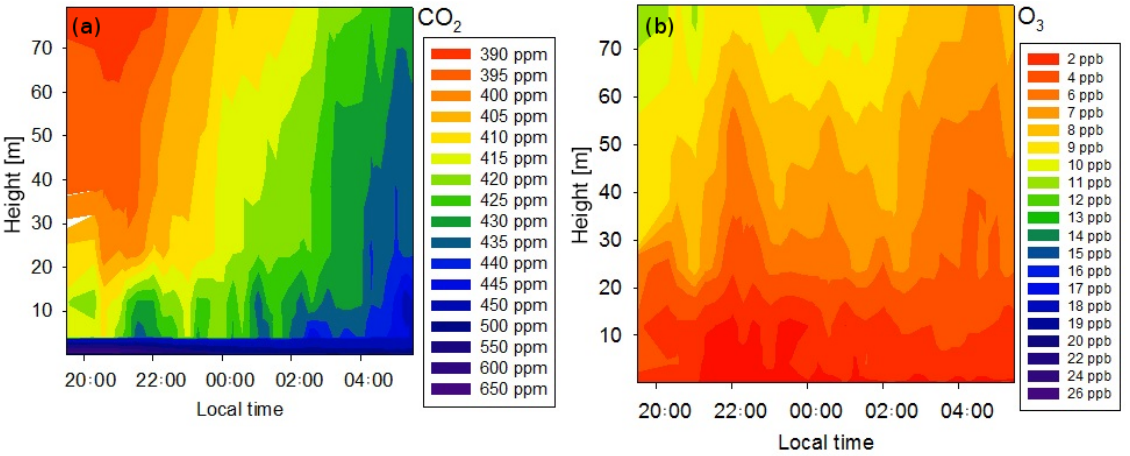
Figure 3. Concentrations of CO 2 (a) and O 3 (b) as a function of time and height for the turbulent